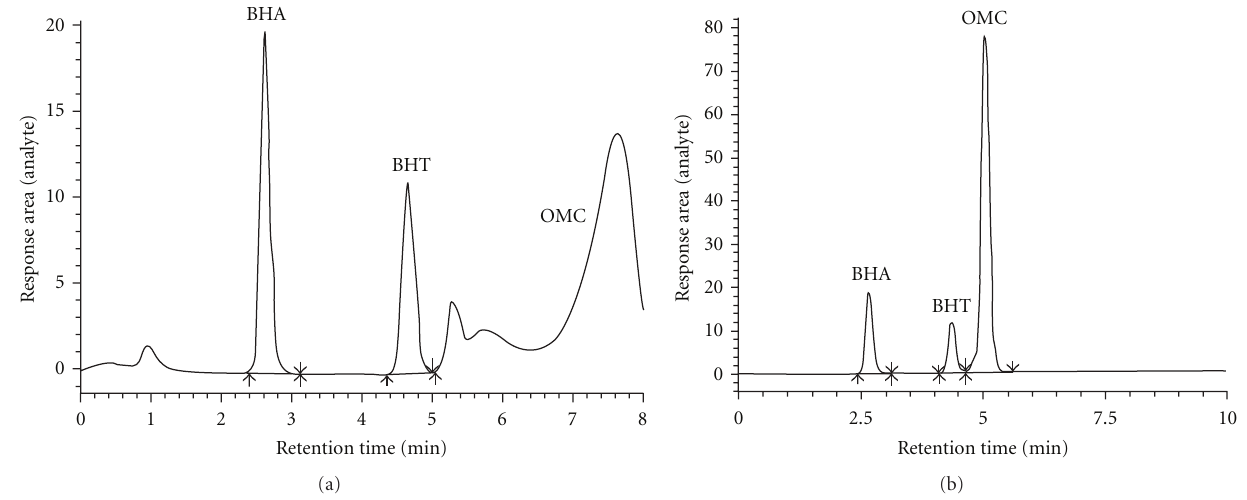
Figure 3: Chromatogram of BHA, BHT, and OMC analyzed using RP-HPLC-UV/Vis at λ max = 280 nm (A: pH 7, R s : 0.79 < 1.5 and B: pH 3.5, R s : 1.98 >